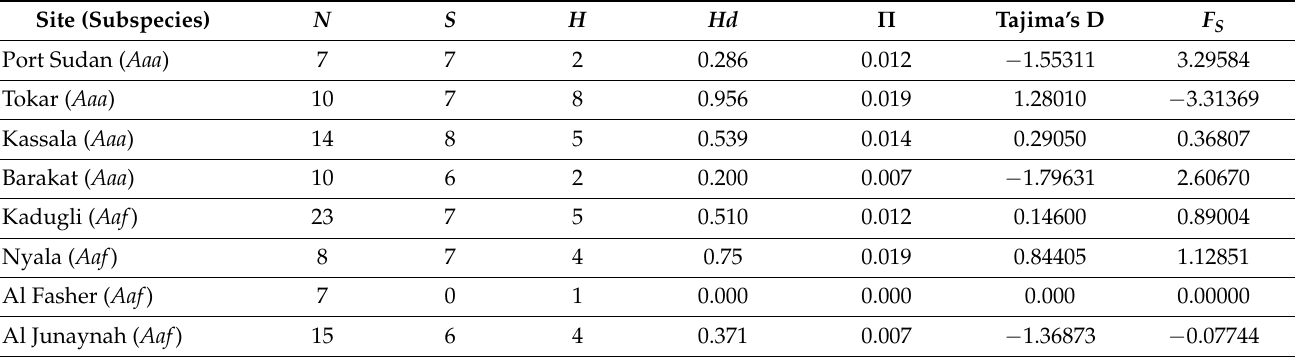
Table 2. The haplotype number, diversity, nucleotide diversity and neutrality tests for ND4 gene samples of Aedes aegypti from